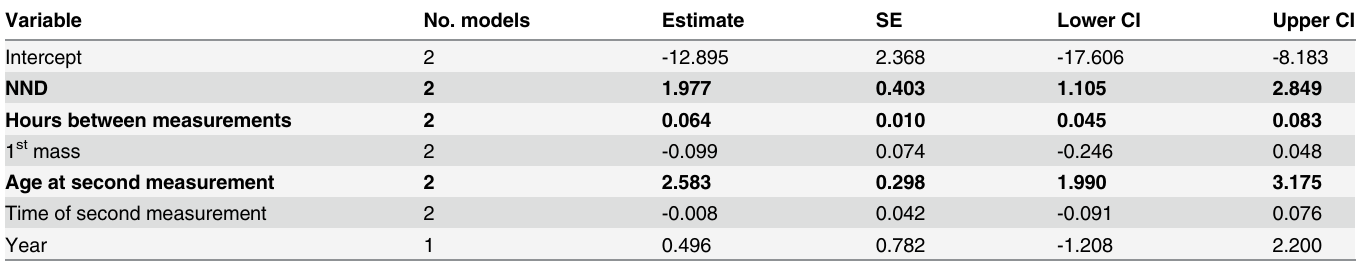
Table 8. Averaged model estimates and 95% confidence intervals from the two top models predicting nestling mass growth rate (Marginal R 2 = 0.65; Conditional R 2 = 0.99).